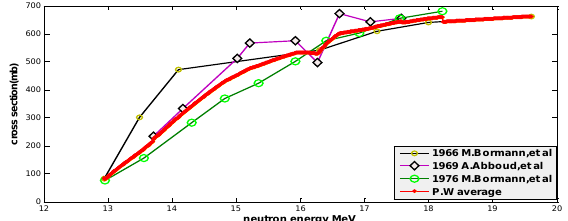
on 74 Se was calculated using equation (4) and shown in Fig.11 and table 2, According to M.Bormann,et al (16) , A.Abboud,et al (17) and M.Bormann,et al (18).